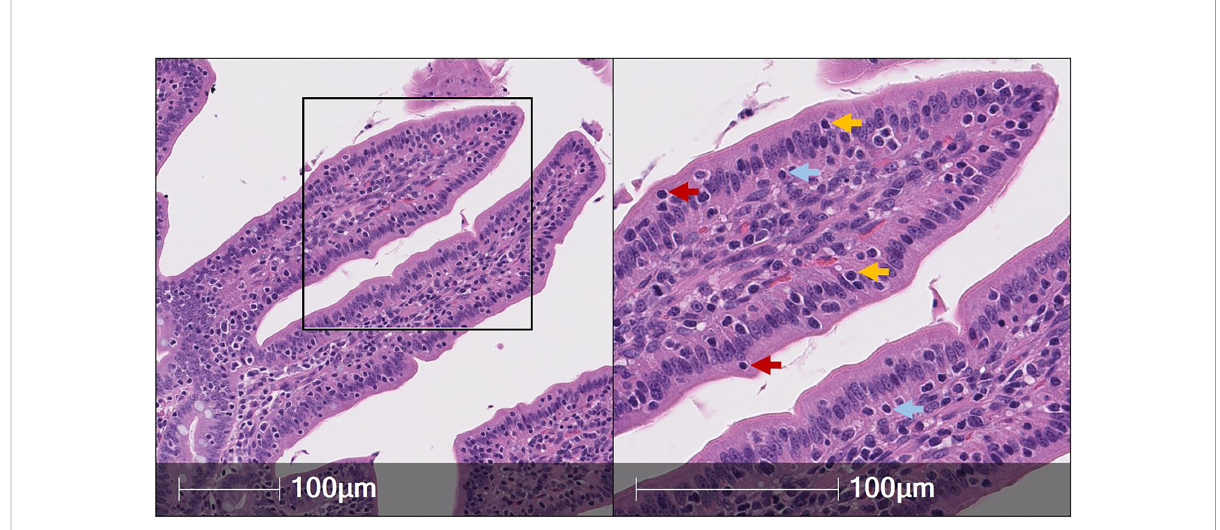
FIGURE 1 Identi fi cation of IELs from H&E staining in pig intestine. H&E-stained tissue section of jejunum from a ~9-week-old pig. IELs are identi fi ed as dark purple, round nuclei within the epithelial layer. Two each of IELs in apical epithelium (red arrows), nuclear-level epithelium (gold arrows), and basement membrane (light blue arrows) are indicated in the panel on the right. H&E (hematoxylin and eosin); IEL (intraepithelial